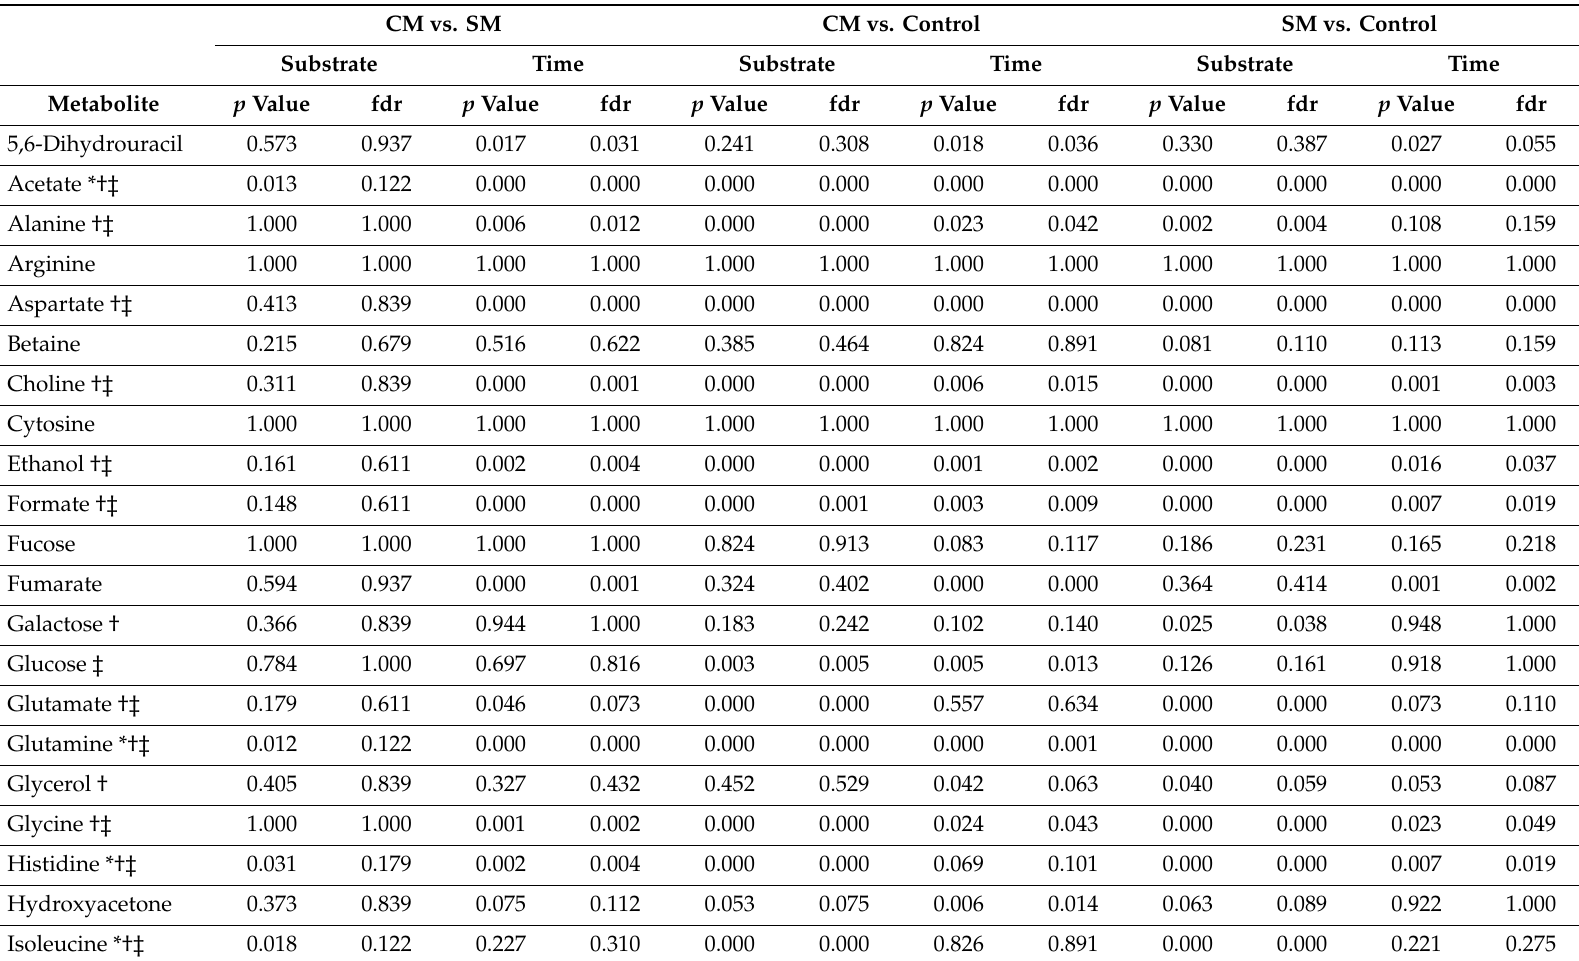
Table A6. Metabolites detected by NMR in five-month-old fecal fermentations, analyzed using ANOVA. CM vs.